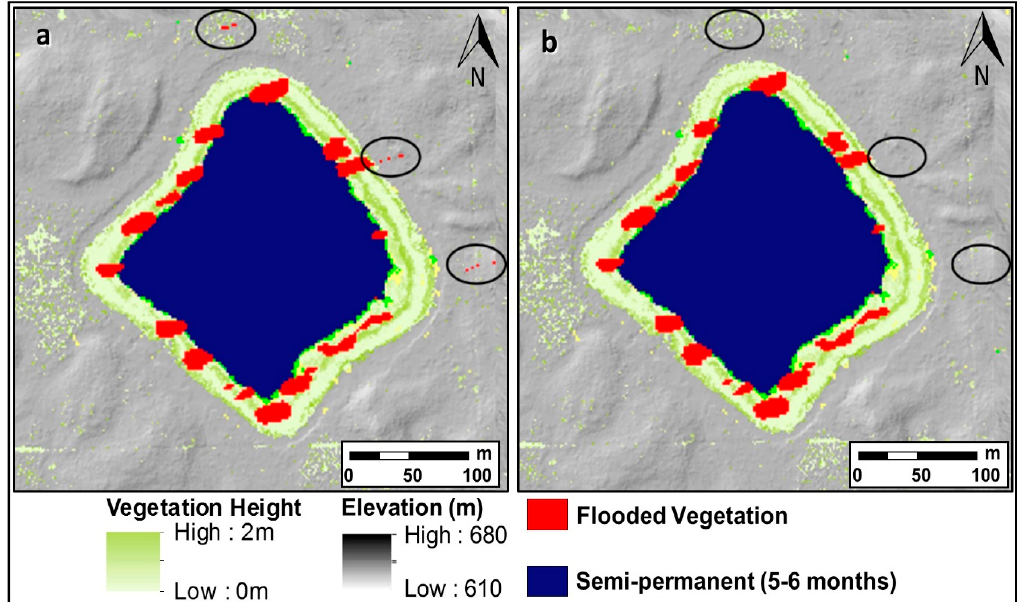
Figure 7. ( a ) Wetland with flooded vegetation commission errors outside of wetland riparian area and within surface water, ( b ) corrected flooded vegetation raster mask.